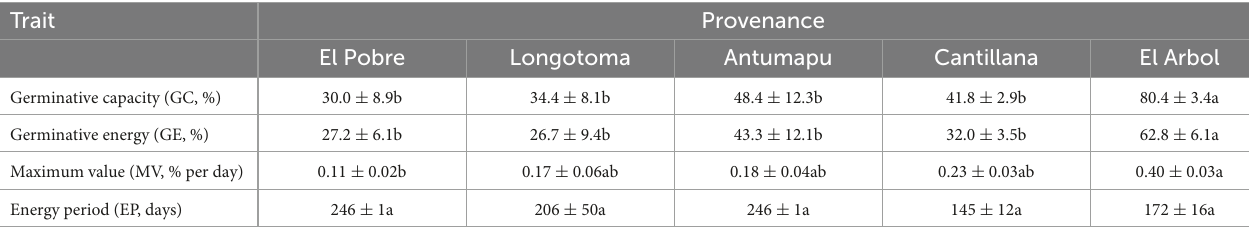
TABLE 2 Means and standar error for the seed germination parameters by provenance of Beilschmiedi miersii .